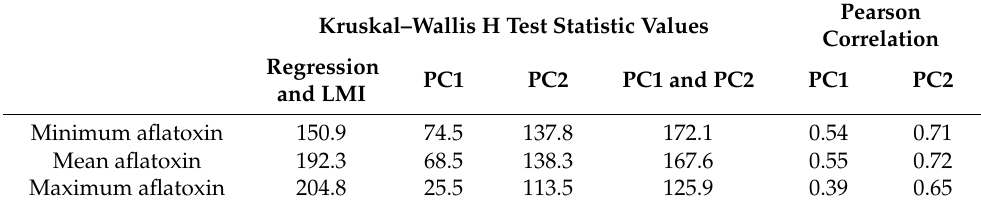
Table 4. Summary of Kruskal–Wallis H tests to determine the best method for defining aflatoxin risk zones and Pearson correlations between PC1 and PC2 and the aflatoxin